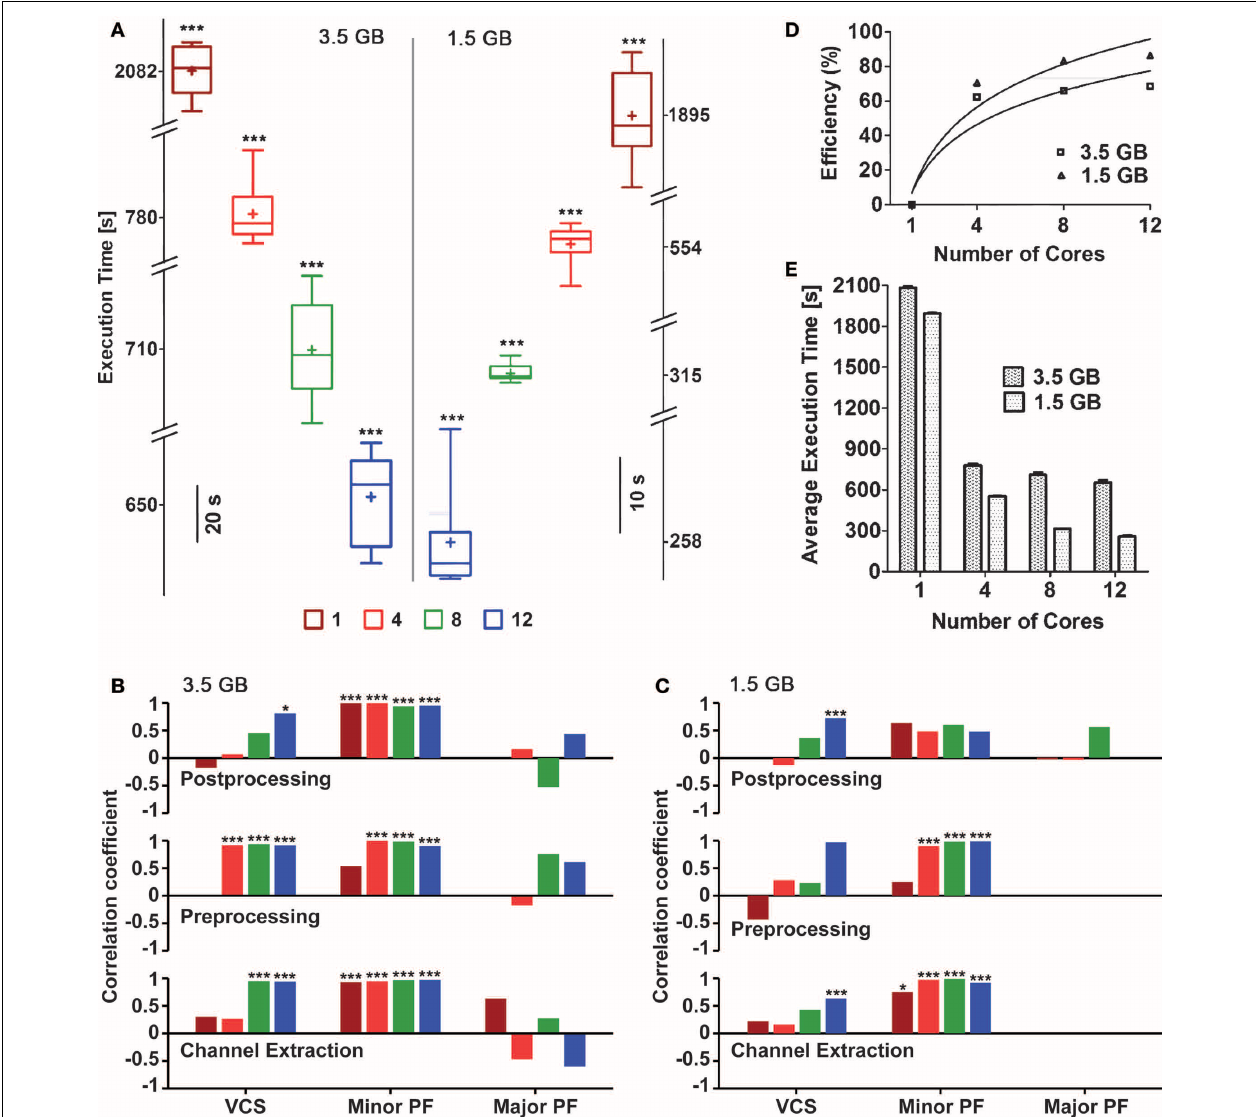
FIGURE 5 | Execution times and efficiency, for an increasing numbers of cores reserved. Box plots (A) with box height showing 25–75% of the sample values were used to represent maximum and minimum (whiskers), median (“ − ”) and mean (“ + ”) execution times, respectively, which were all significantly different ( p < 0 . 05) based on the number of cores used. The vertical line in the middle separates the data representation corresponding to distinct file sizes (3.5 vs. 1.5GB). Pearson’s liner correlation coefficients (B,C) show that the execution times of individual sub-processes are correlated to, certain computationally intensive operations performed by the operating system such as, minor page faults (Minor PF), and voluntary context-switching (VCS) ( ∗∗∗ p < 0 . 0001; ∗ p < 0 . 05) in case of large file